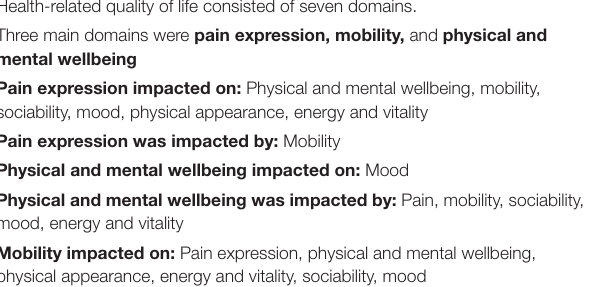
TABLE 1 | Narrative of conceptual framework. Health-related quality of life consisted of seven